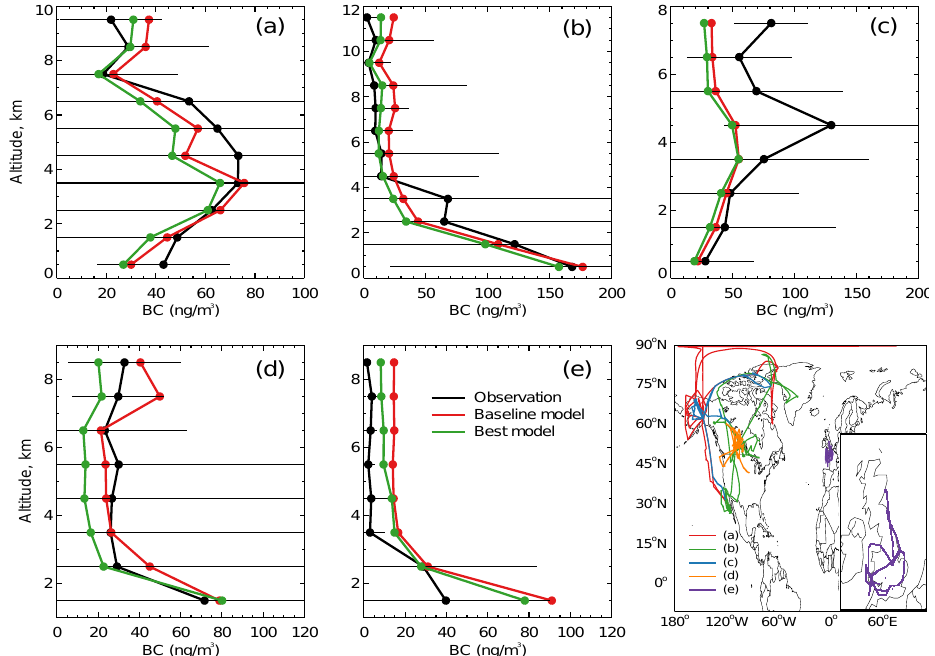
Figure 5. The observed (black) and “baseline” (red) and “best” (green) simulated black carbon median vertical profile during (a) ARCTAS DC8, April 2008; (b) ARCTAS DC8, June–July 2008; (c) ARCTAS P3B, April 2008; (d) ARCTAS P3B, June–July 2008 and (e) EUCAARI, April and September 2008. The related flight tracks are shown on the bottom right corner. The error bars show the standard deviations of measurements averaged in each vertical bin. Note the different scale among